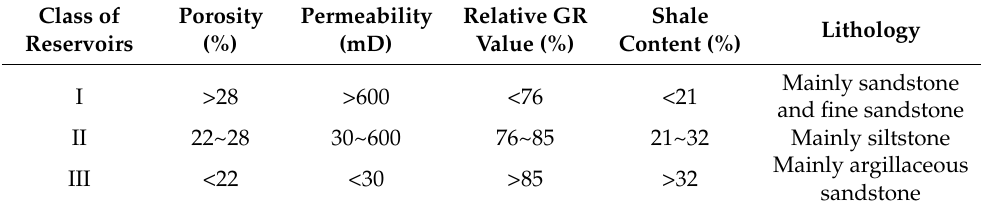
Table 4. Logging interpretation results of